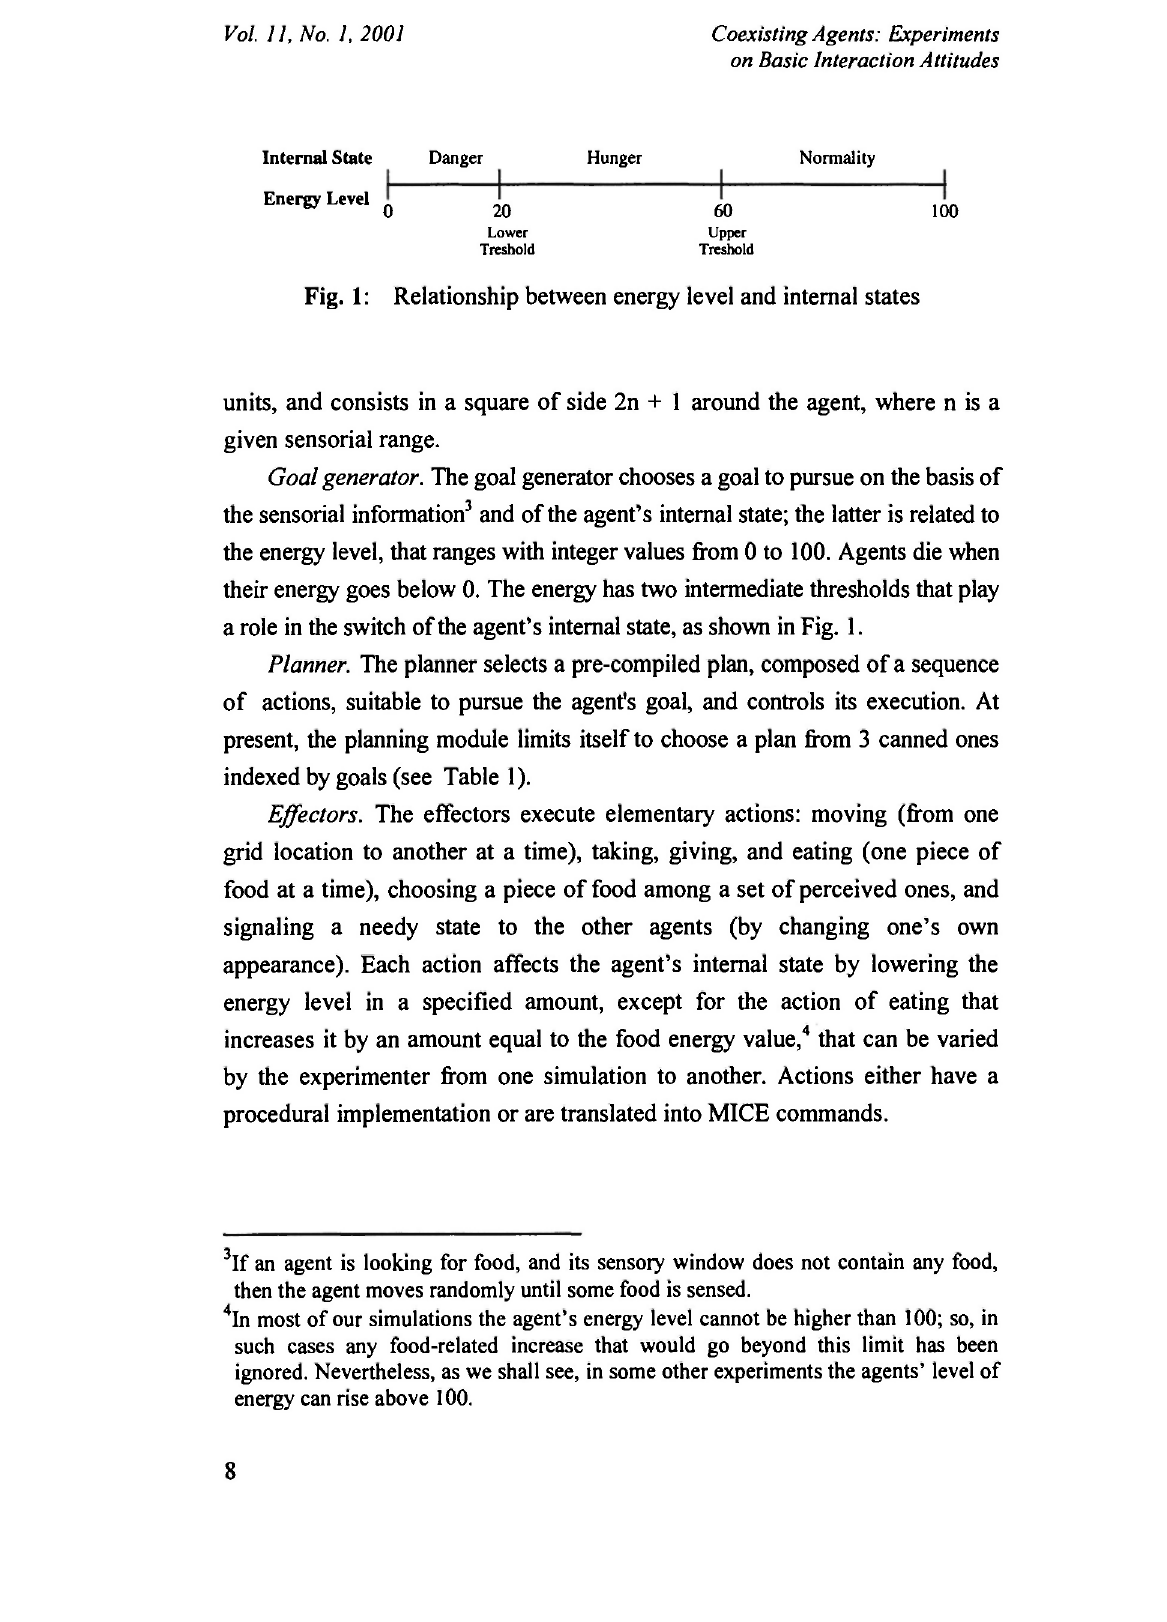
Fig. 1 : Relationship between energy level and internal states